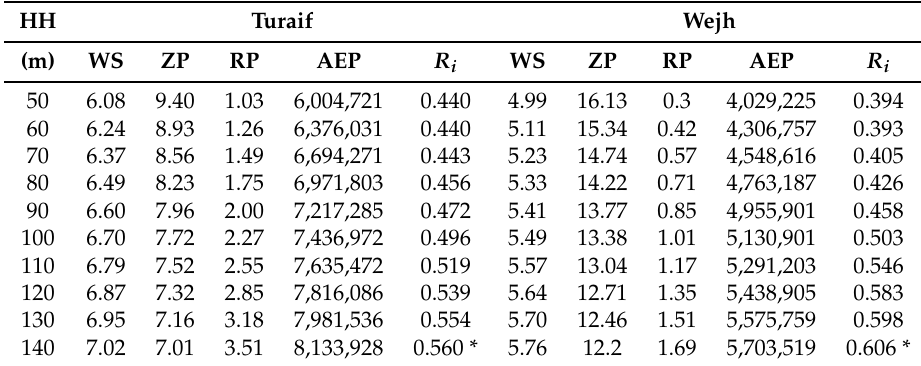
Table A14. TOPSIS analysis for turbine Vestas V112. The best choice for each site is marked with an asterisk.